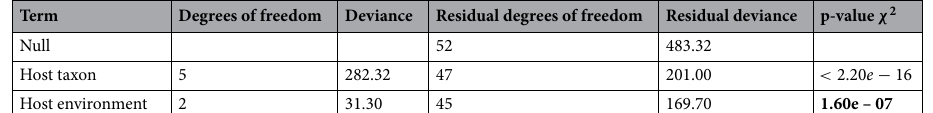
∼ Host Taxon + Host Environment) fitted for Callithrix gut